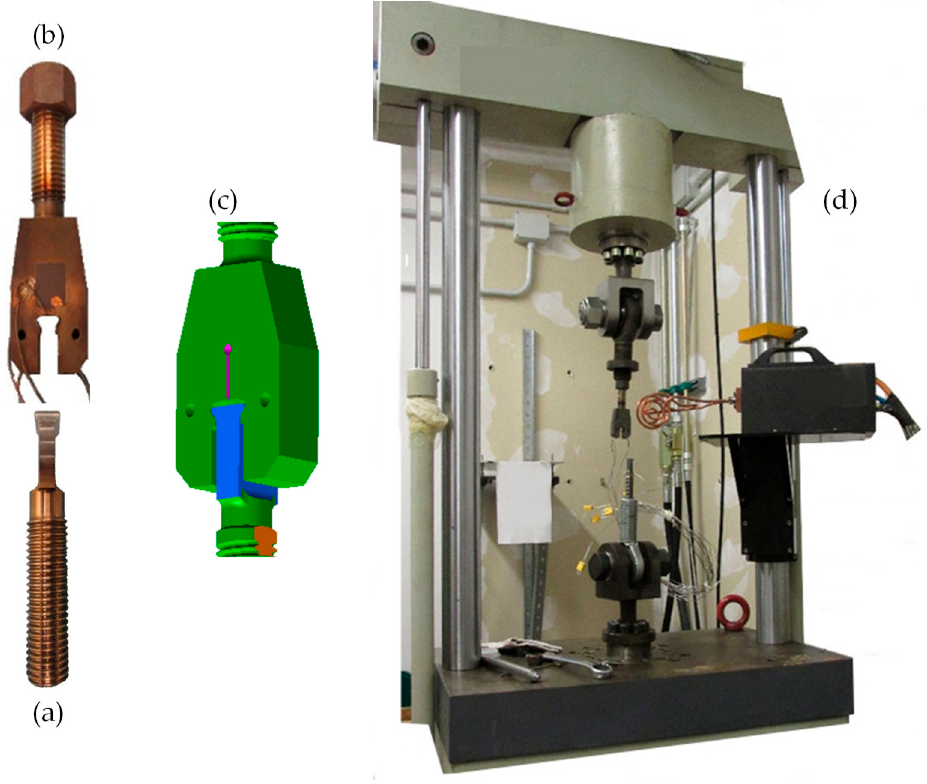
Figure 1. Test rig: ( a ) model of blade root; ( b ) model of disk cavity; ( c ) assembly of disk and blade root; ( d ) overall view.